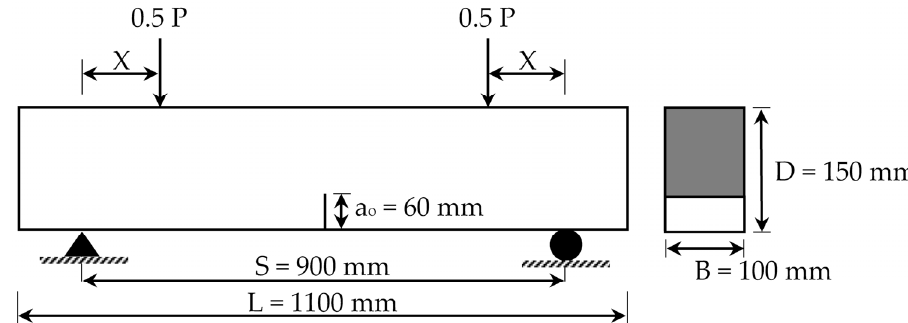
Figure 8. Four-point loading scheme for T6 .